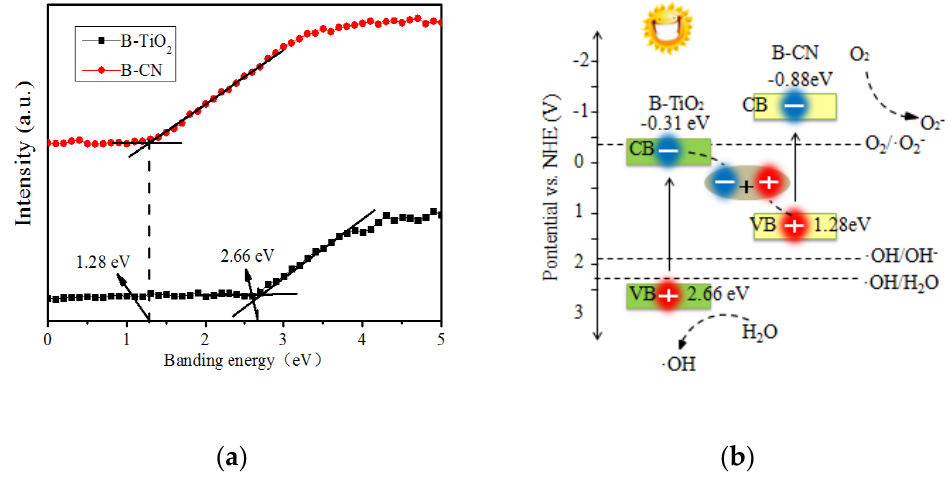
Figure 9. Spectrum of DMPO spin trapping ESR of different materials ( a ) DMPO-O 2 − and ( b ) DMPO- ·OH.